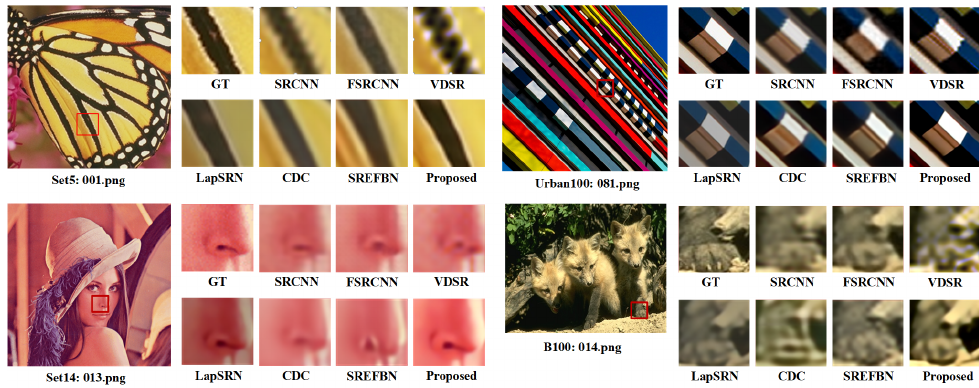
Figure 7. Visual comparisons with different methods for 4 × super-resolution on the Set5, Set14, B100, and Urban100 datasets.